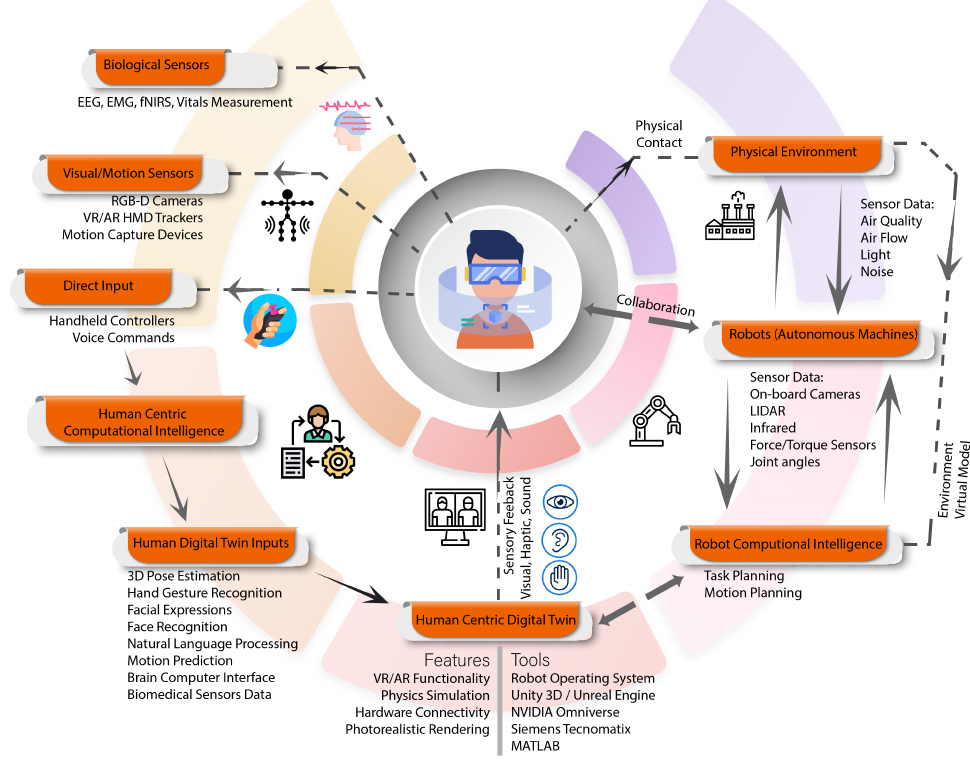
Figure 6. Enabling Technologies and framework of Human-Centric Digital Twins in Industry